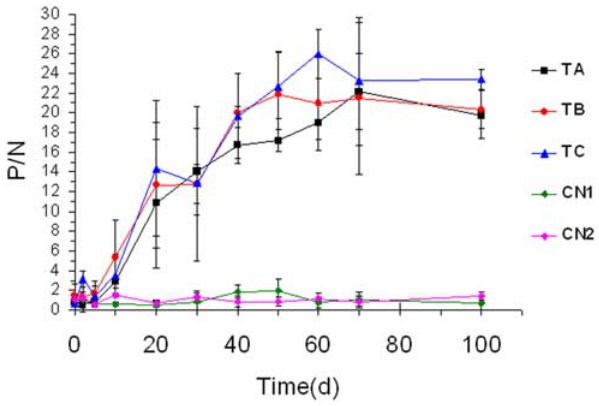
Figure 5. Anti-HA antibody titers of the vaccinated monkeys in a long-term